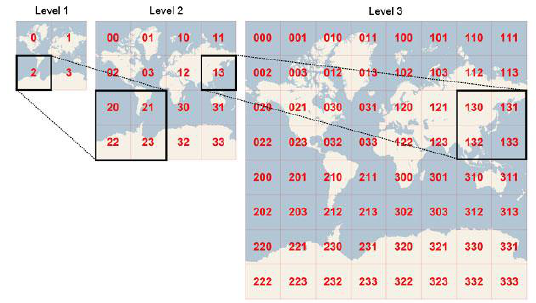
Figure 1. Typical tile layout of a global dataset (Microsoft 2008)